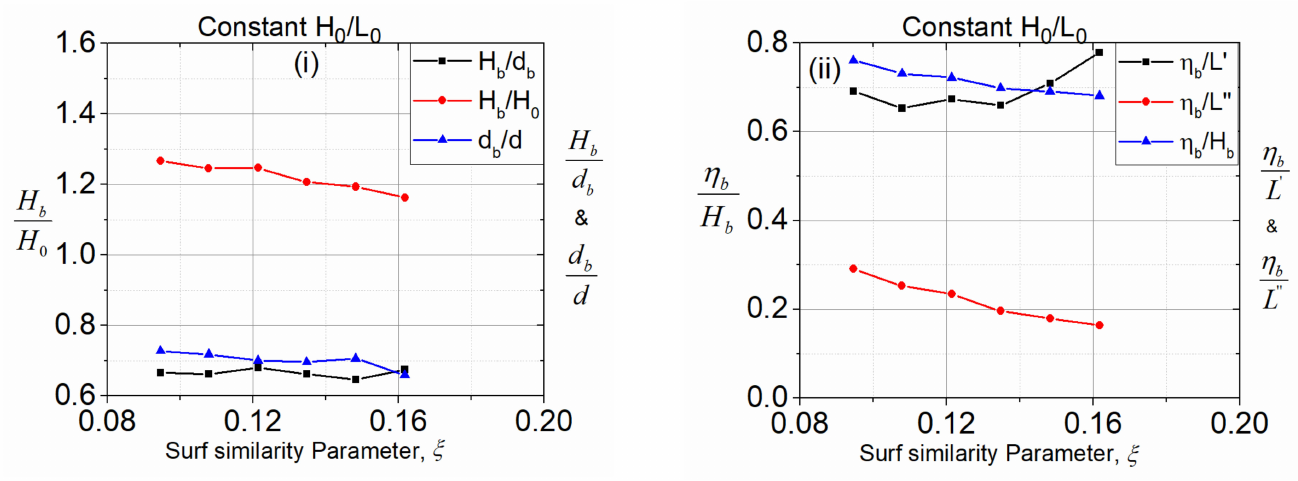
Figure 10. Computed breaking wave parameters vs. surf similarity parameter for varying slope and constant wave steepness ( H 0 / L 0 ) ( i ) Relative breaker depth ( d b /d ), breaker depth index ( γ b ), and breaker height index ( Ω b ) vs. surf similarity parameter ( ξ ); and ( ii ) wave crest front steepness ( ε ), wave crest rear steepness ( δ ), and horizontal asymmetry factor ( µ ) vs. surf similarity parameter ( ξ